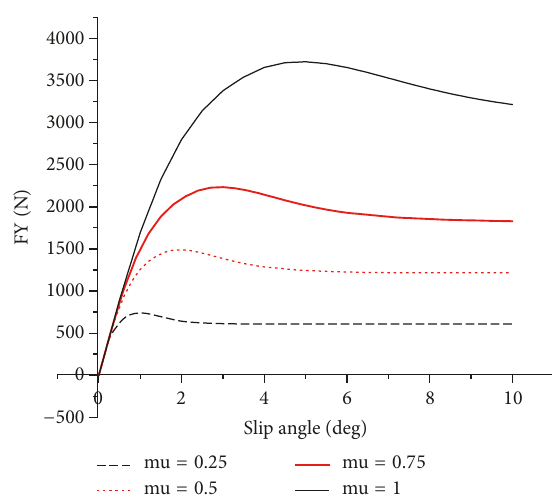
Figure 4: Lateral tire forces under different road friction